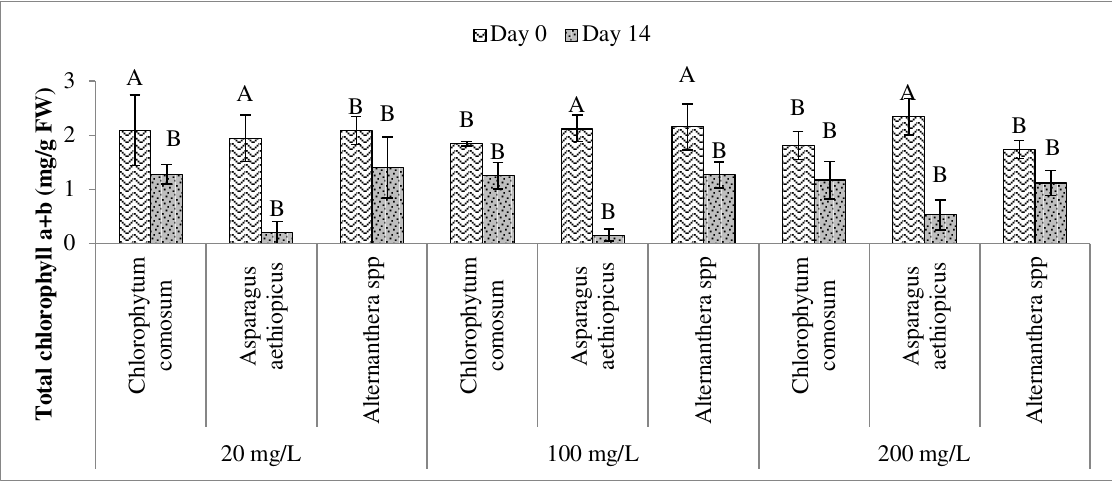
Fig. 4. Chlorophyll content (a+b) in methylparaben-exposed systems. Error bars refer to standard deviation